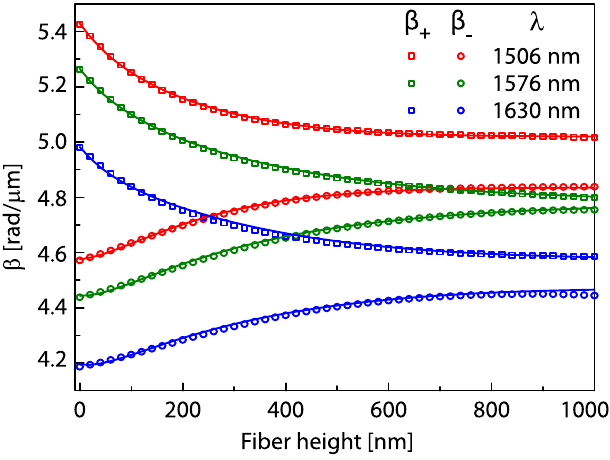
FIG. 7. Propagation constants ( β (cid:2) ) of the even and odd supermodes of the coupled nanobeam and fiber taper wave- guides, as a function of waveguide separation h , for varying λ . Points indicated by open squares and circles where calculated using Lumerical MODE Solutions. Solid lines are fits using the coupled mode theory model described in Appendix C.